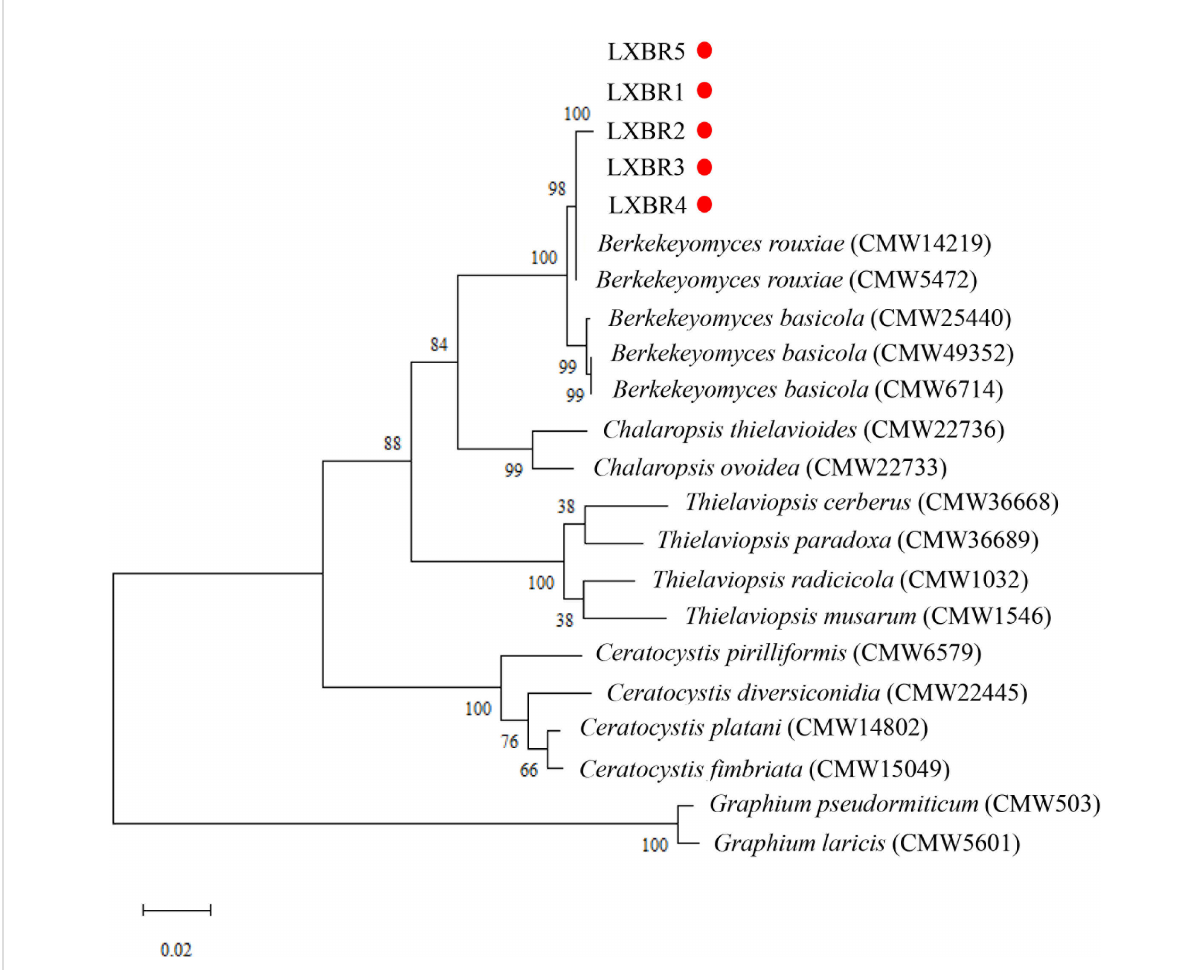
FIGURE 3 Combined phylogenetic tree based on the ITS, LSU, 60S, and MCM7 sequences of the Berkeleyomyces rouxiae isolates by Maximum-Likelihood method in the MEGA11with bootstrap values estimated by 1000 replicates. Bootstrap support values are indicated in the